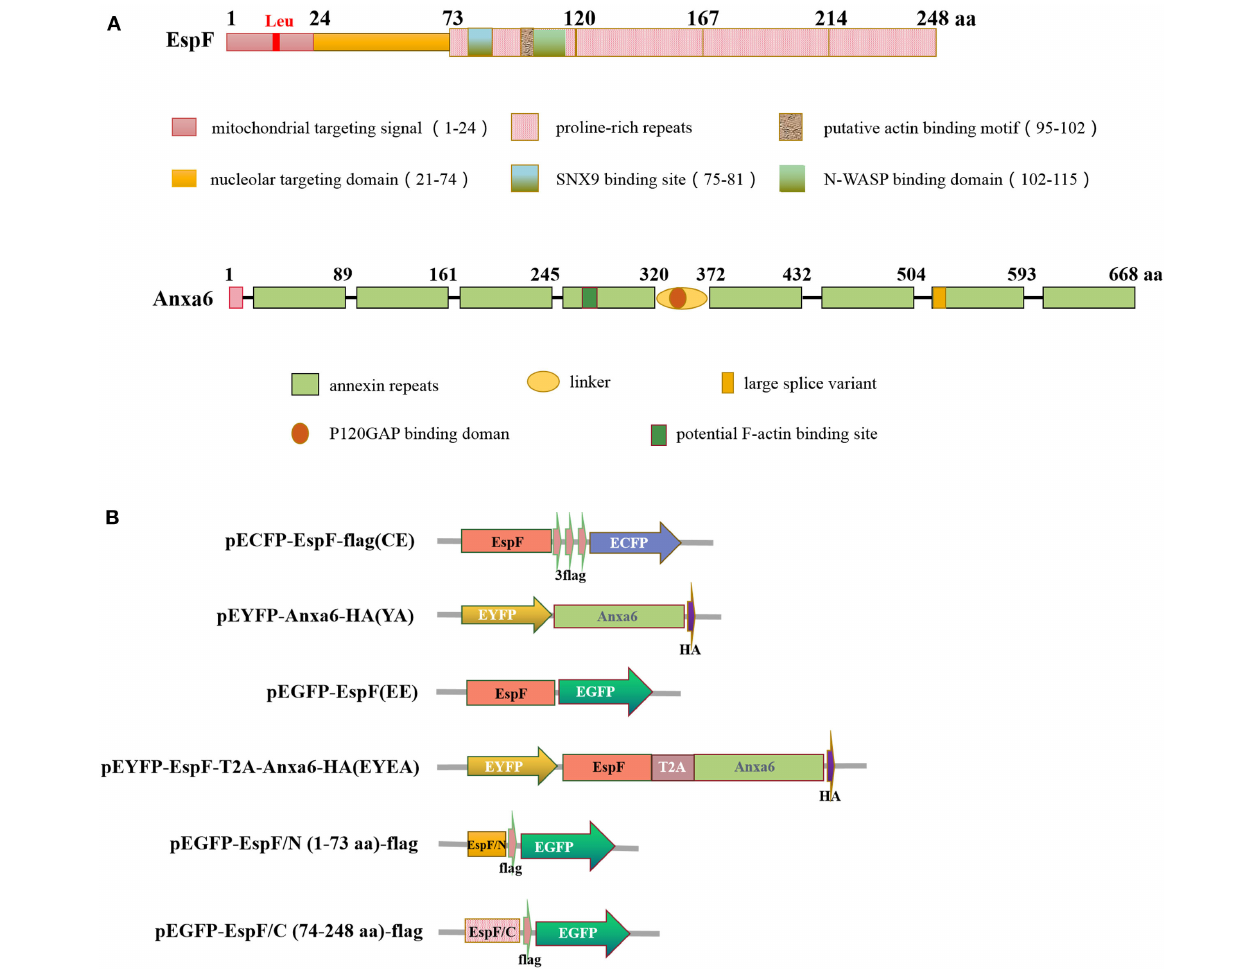
( Figure 1B ). We investigated the function of the EspF- ANXA6 complex by co-expressing CE and YA in HEK293 cells. ECFP served as a FRET donor and EYFP as the acceptor; the emission spectrum of ECFP overlaps with the absorption spectrum of EYFP. When the fluorescence emitted by the donor overlaps with the absorption spectrum of the acceptor chromophore, and the distance between the two proteins is < 10 nm, a FRET phenomenon occurs (Algar et al., 2019), indicating an interaction between the two proteins ( Figure 2A ). HEK293 cell lines co-transfected with pECFP-N1 and pEYFP- C1 were set as a negative control (NC). Cells transfected with pECFP-YFP were a positive control (PC). Cells co-transfected with CE and YA were the experimental group (EX). The FRET efficiency of each group was assessed by fluorescence